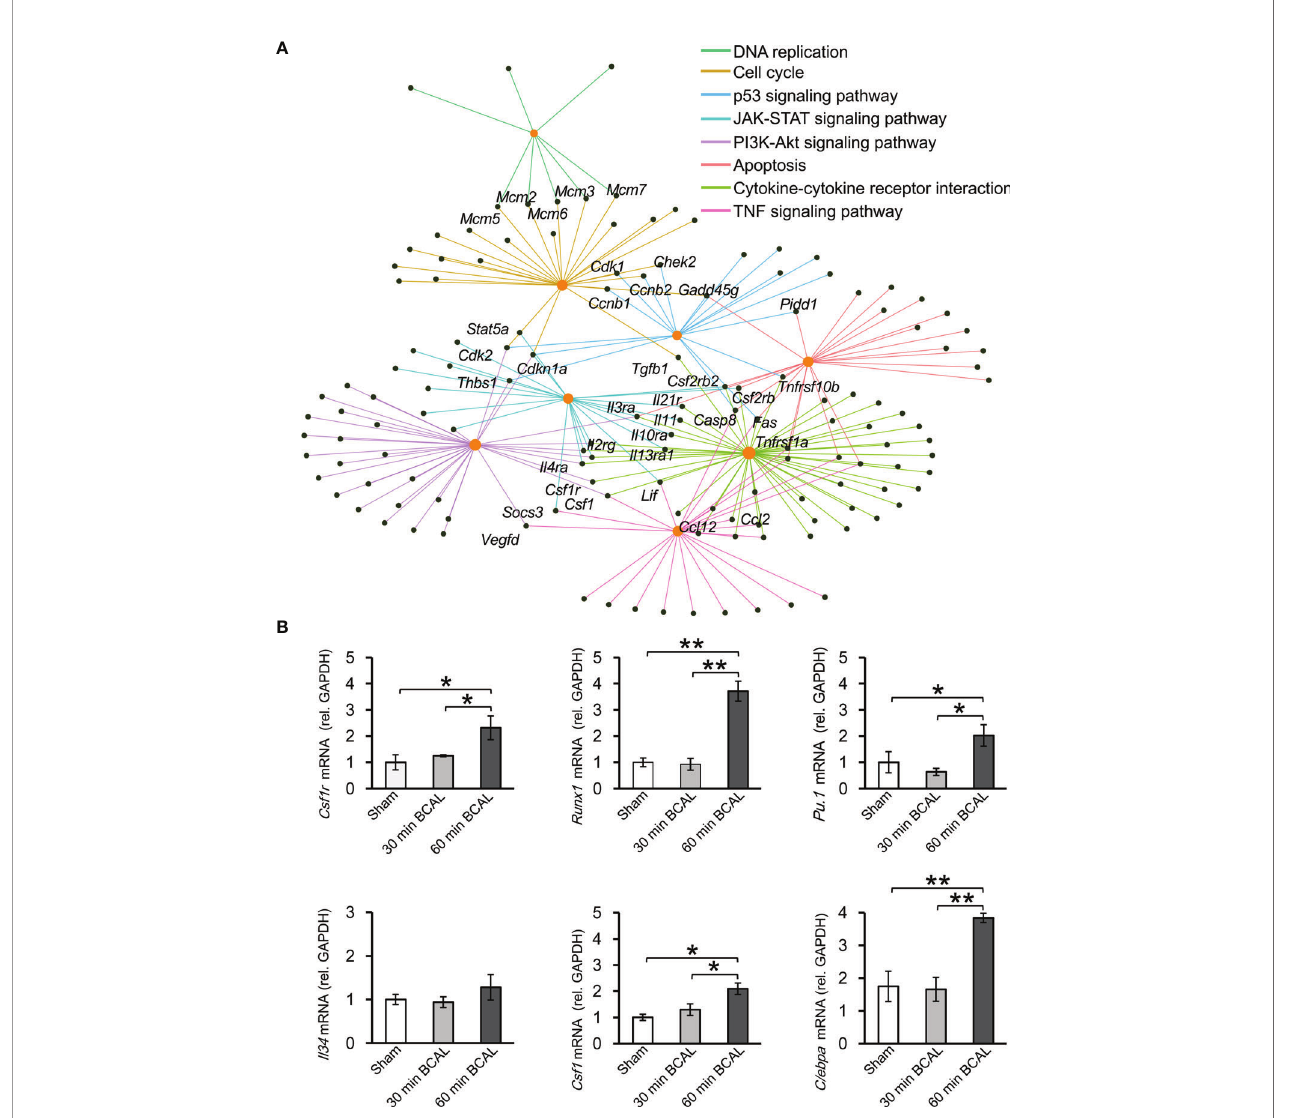
FIGURE 6 | Regulatory network and key regulatory factors in 60 min ischemia. (A) Regulatory network of KEGG terms in 60 min BCAL. Orange nodes indicate KEGG terms, and black nodes indicate overlapping genes. (B) qRT-PCR was used to validate the result of RNA sequencing. The expression level of mRNA was normalized to GAPDH . CSF1 related genes including CSF1R , Runx1 , PU.1 and Cebpa were upregulated in 60 min ischemia, and the expression level of IL34 showed no signi fi cant difference between each group. These data are in agreement with DEG data. (n = 4 mice for each group; * p < 0.05 and ** p <